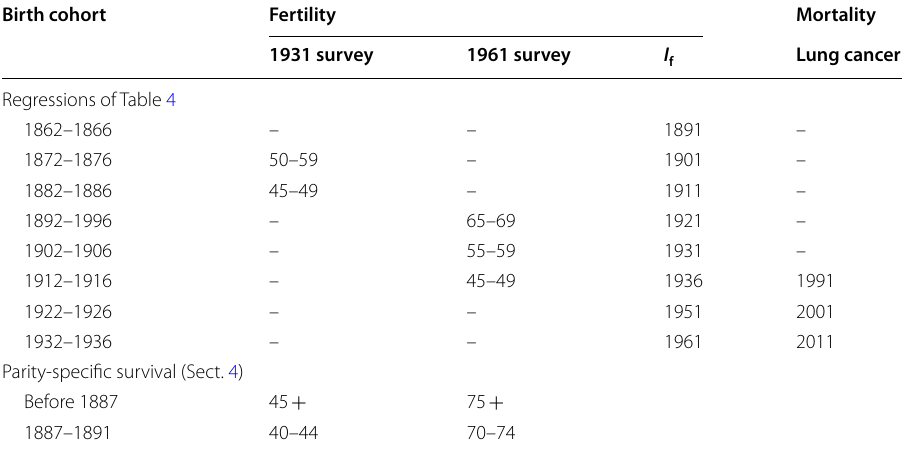
Table 3 Sources of information on fertility (and lung cancer mortality) for selected Italian